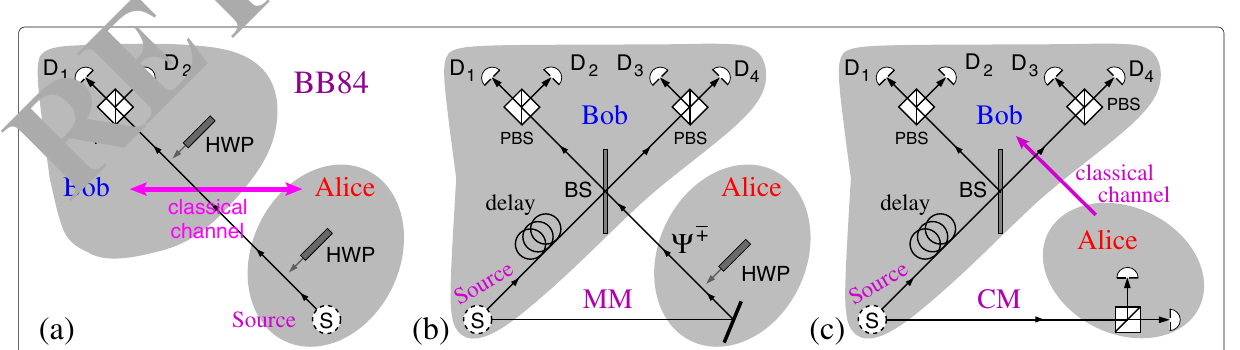
Fig. 1 Schematics of BB84 and ping-pong (pp) protocols. a BB84—classical and quantum channels are merged. b MM of the pp protocol—quantum channel. c CM of the pp protocol—classical